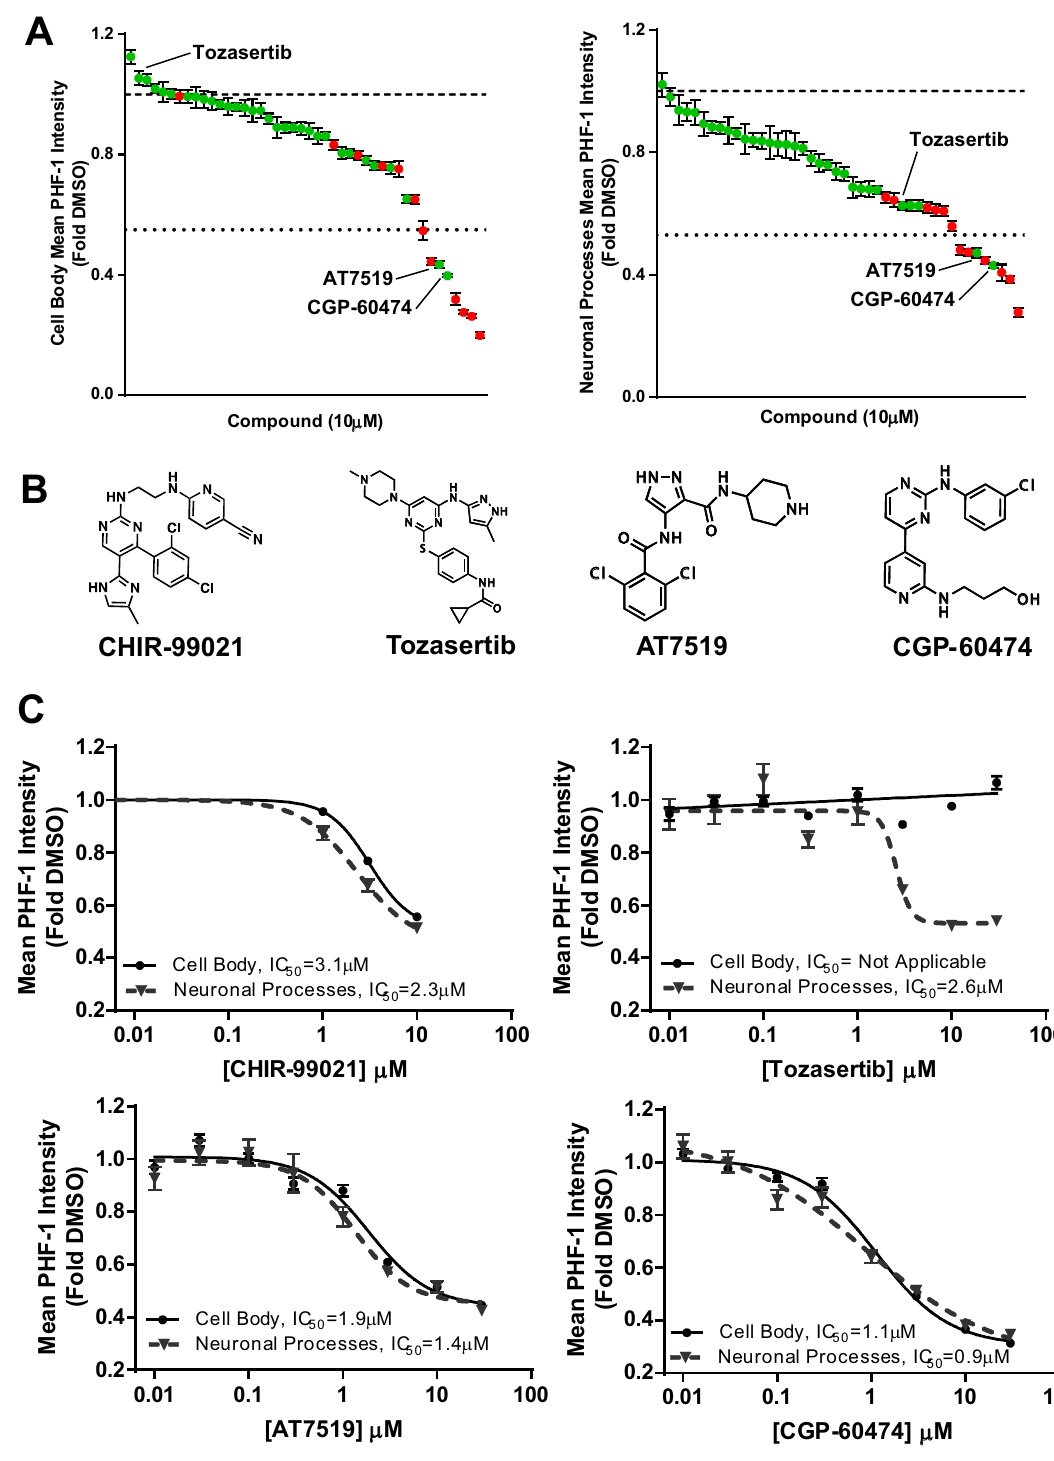
Figure 8. Effect of compounds from a custom collection of 44 small molecule kinase inhibitors on p-Tau (PHF-1) in human Tau-A152T neurons. ( A ) Waterfall plot of effect of 10 µM compound of a subset of HMS LINCS kinase inhibitor library on p-Tau (PHF-1) in the cell body (left panel) or neuronal processes (right panel). Dashed (upper) line represent effect of DMSO (set at 1), dotted (lower) line represents effect of 10 µM CHIR-99021. Green dot represents no or minimal effect (≤ 20% decrease) of compound on neurite area, red dot represents adverse effect (> 20% decrease) of compound on neurite area. Values are mean ± SEM. ( B ) Chemical structure of CHIR-99021 and three of the hit compounds, Tozasertib, AT7519 and CGP-60474. ( C ) Concentration response curves of CHIR-99021 and three of the hit compounds on p-Tau (PHF-1). The compound hits, AT7519 and CGP60474, dose-dependently decreased the mean p-Tau (PHF-1, Tau-pS396/pS404) intensity in both the neuronal processes and cell body more potently than CHIR-99021 (our positive control in the assay), whereas Tozasertib only dose-dependently decreased the mean p-Tau intensity in neuronal processes. Each point is the mean ± SEM of four biological